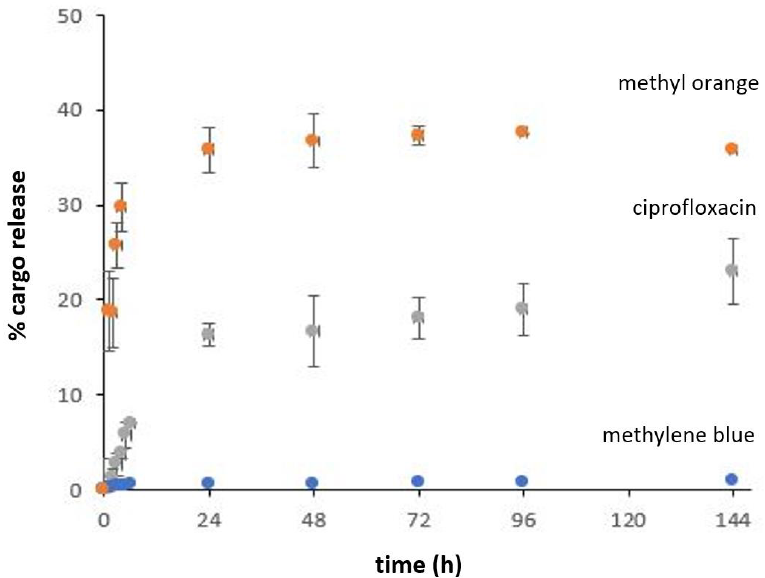
Figure 12. Percentage release of methylene blue, methyl orange, and ciprofloxacin from hydrogel 1 over time.